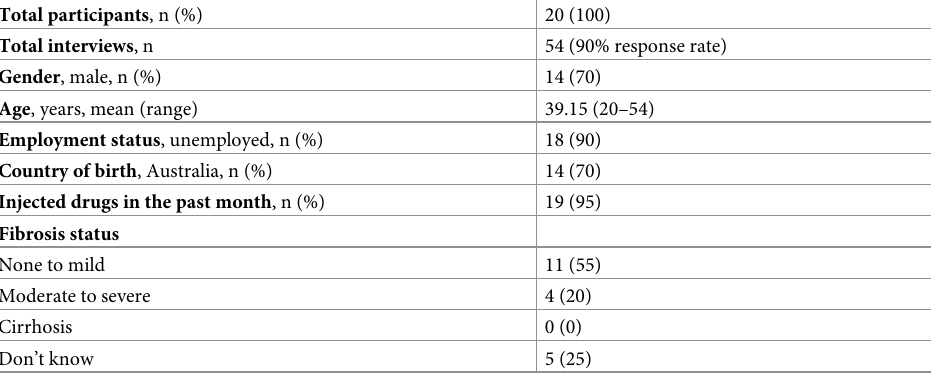
Table 1. Participant demographic characteristics at baseline (N =